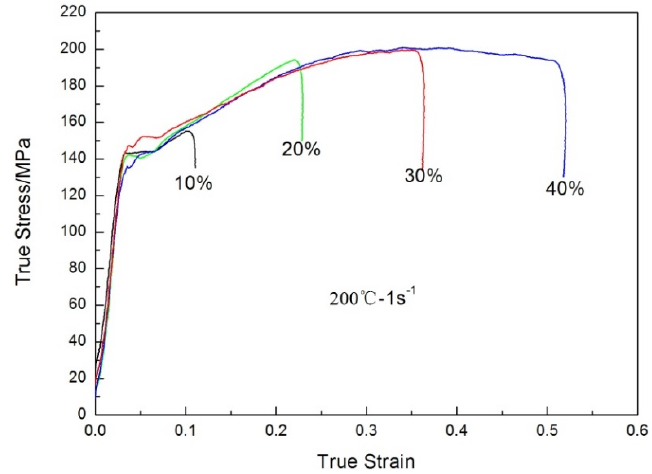
Figure 5. True stress–strain curves of the as-extruded 0.05 wt.% ND/ZK60 composite with different strain at the deformation temperature of 200 °C and a strain rate of 1 s −1 .